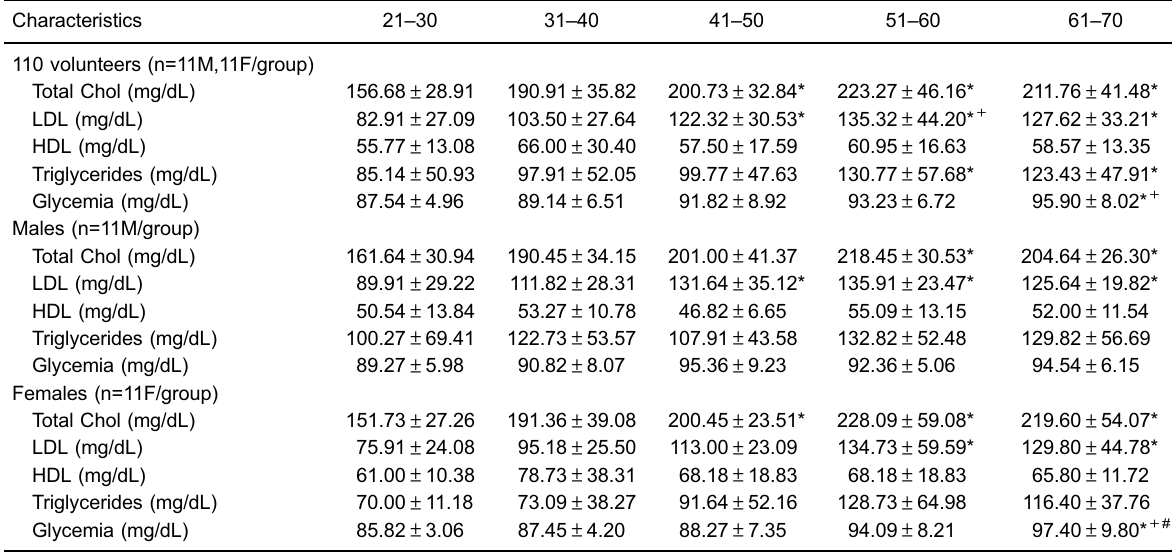
Table 1. Overall biochemical results according to age groups (in years) and according to sex and age groups.